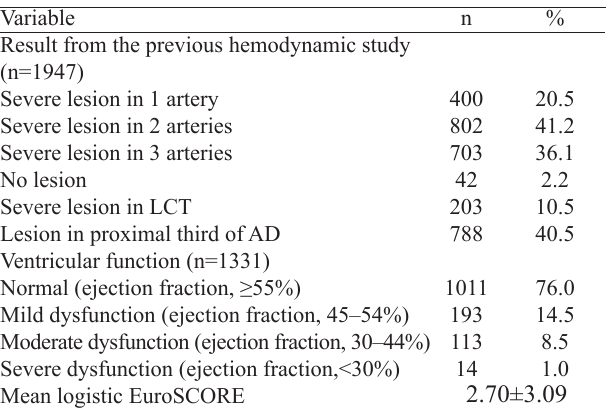
Table 2. Angiographic characteristics, ventricular function, and EuroSCORE of patients who underwent coronary artery bypass grafting, São Paulo,